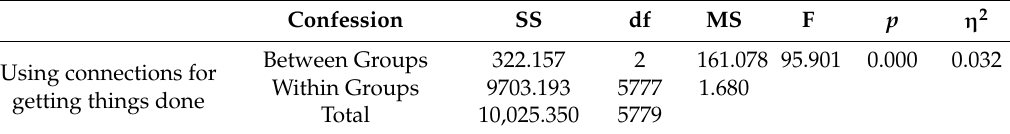
Table A4. Using connections for getting things done among confessions.